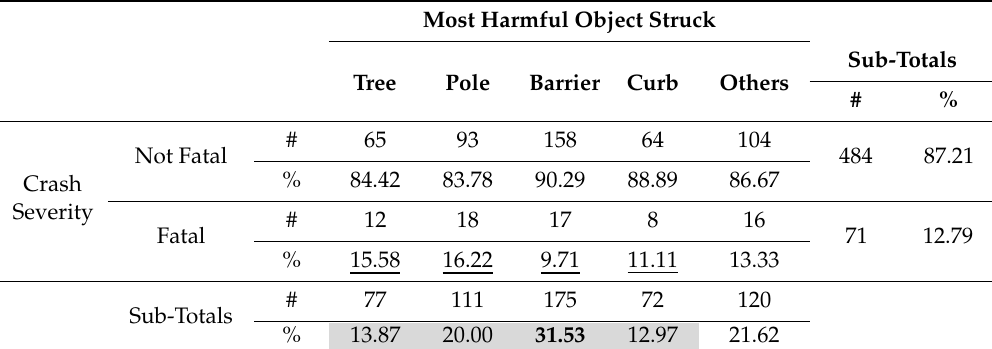
Table 2. Crash Severity Distribution by Most Harmful Object Struck